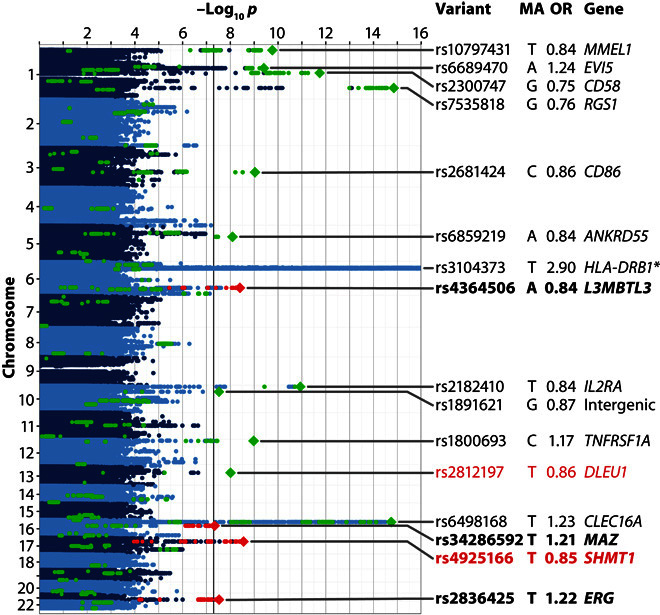
Genome-wide representation of MS associations in the pooled analysis of German data sets.Manhattan plot showing strength of evidence for association (P value). Each variant is shown as a dot, with alternating shades of blue according to chromosome. Green dots represent established MS-associated variants and their proxies, as listed by Sawcer et al. (3) (except for rs2812197, which was not covered by that review). Top variants at the 15 non-MHC loci associated at the genome-wide significance threshold in our study are shown as diamonds. Novel variants showing genome-wide significance are plotted as red diamonds; their names are shown in bold font. Variants in high LD (r2 ≥ 0.7) with these novel variants are shown as red dots. Variants replicating in the Sardinian cohort are shown in red font. MA, minor allele. The OR is relative to the MA. Gene names for known loci are indicated as listed by Sawcer et al. (3). The plot is truncated at −log10p = 16 for better visibility; all truncated variants map to the MHC region. The lowest P value (rs3104373, *) was 1.3 × 10−234.